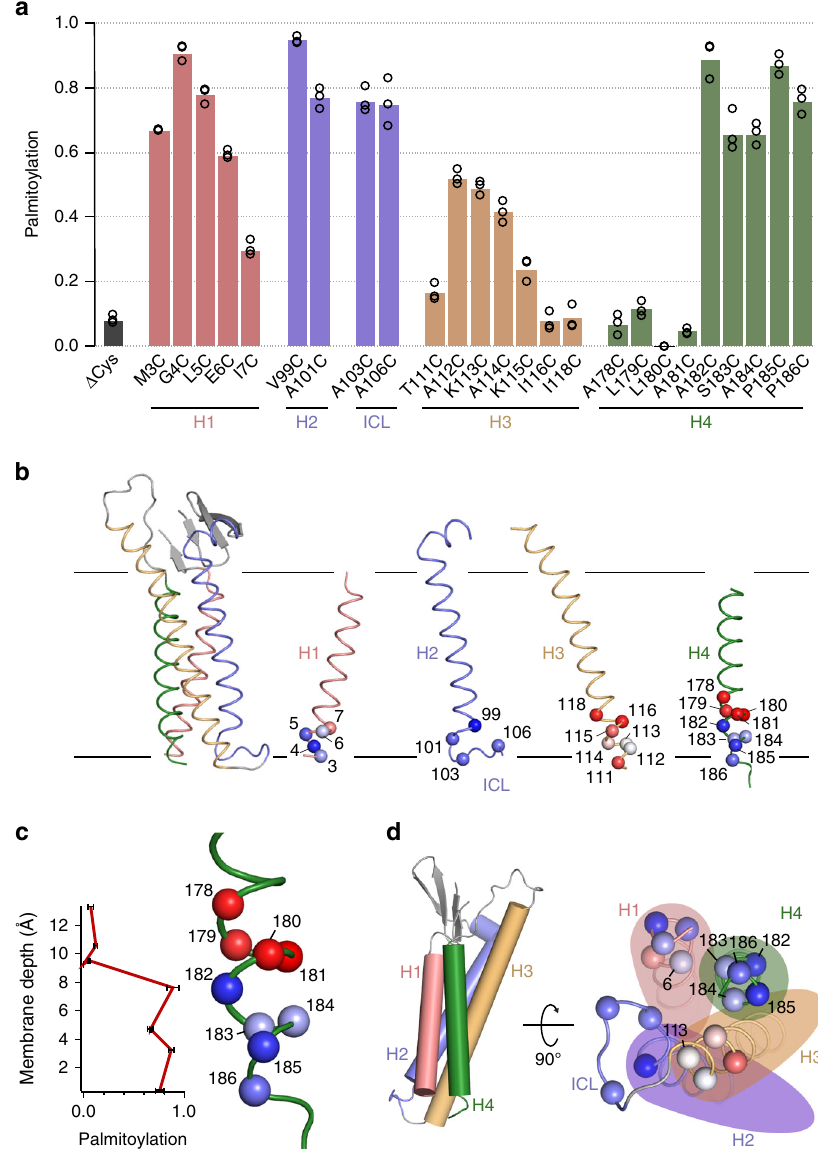
Fig. 2 Palmitoylation status of cysteine-scanned Cld3. a Palmitoylation of single cysteines introduced in Cld3 with all putative palmitoylated Cys 103, 106, 181, 182, and 184 mutated to Ala ( Δ Cys). The average palmitoylation state is obtained by using integrated peak areas of the deconvoluted spectra of intact micelle-released Cld3. No palmitoylation could be observed for Leu 180 Cys because of low expression of this mutant. A palmitoylation state of 0.2 was used as threshold value to classify the introduced Cys as palmitoylation site. Data are presented as mean values of biological triplicates and independent data points are shown as open circles. b Introduced cysteine residues mapped on the Cld3 homology model. In all panels, the C α atom of each cysteine is represented as a sphere colored in a red – white – blue gradient normalized according to its palmitoylation level, in which full palmitoylation is shown as blue, 50% palmitoylation as white no palmitoylation as red. c Cysteine residues introduced in helix 4 are not palmitoylated when located further than 8 Å into the membrane. The membrane depth is the measured distance of the C α atom of the introduced cysteine to the average position of all phosphor atoms of the inner lea fl et after superimposition of the Cld3 model to mCLD19 in MemprotMD. Palmitoylation data are presented as mean values of biological triplicates and error bars represent standard deviations. d Left panel, structural side view of Cld3. Right panel, cytoplasmic view of Cld3 with palmitoylated C α atoms in shown as spheres. The majority of palmitoylated residues are